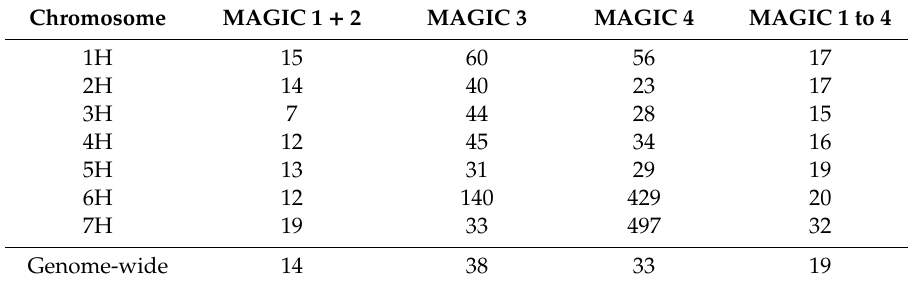
Table 4. Linkage disequilibrium decay (Mbp) for each of the four barley MAGIC populations.